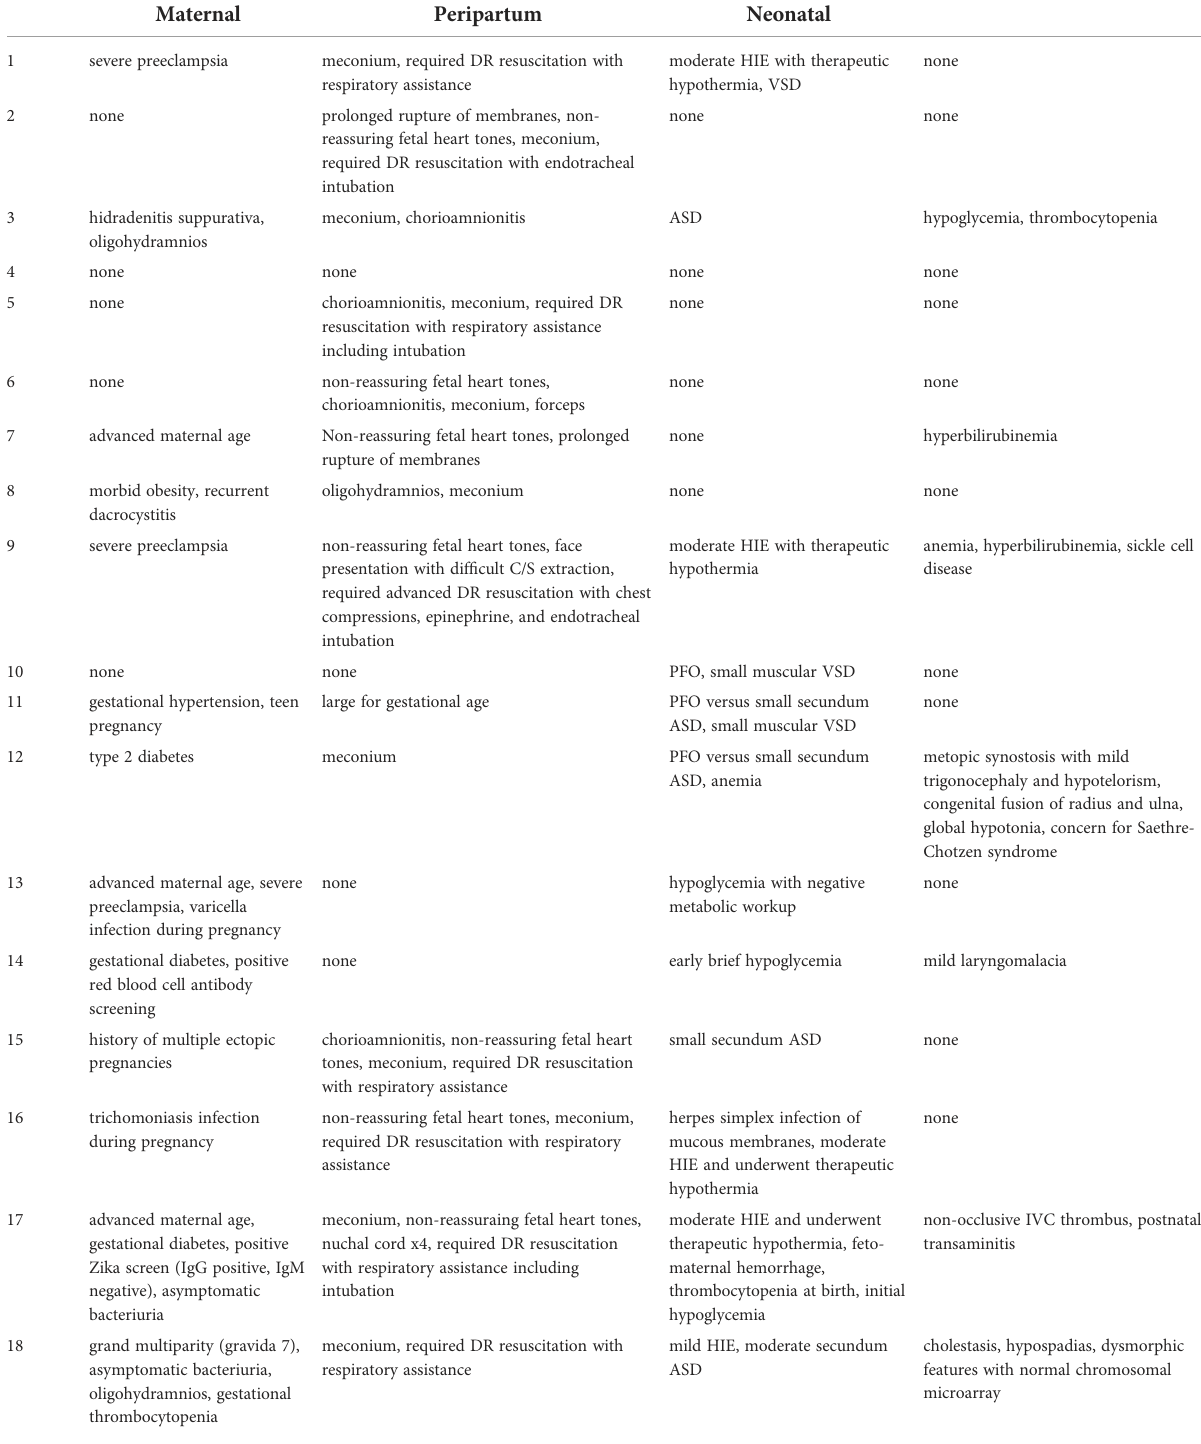
TABLE 3 Stroke risk